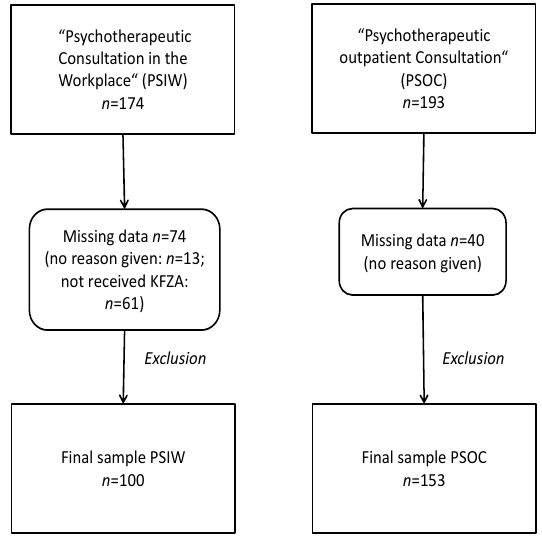
Figure 1. Participant flow chart. KFZA: “Short Questionnaire for Job Analysis”.